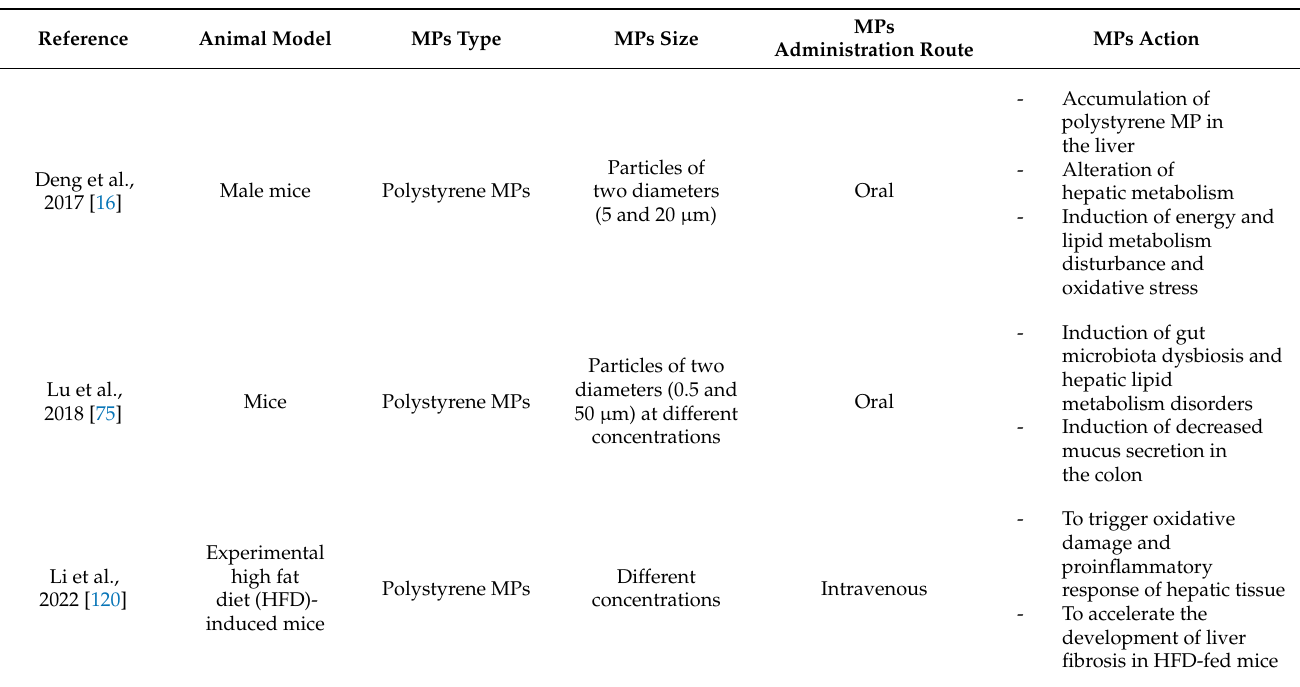
Table 1. Summary of the reviewed literature using in vivo models to study the effect of micro- and nanoplastics on